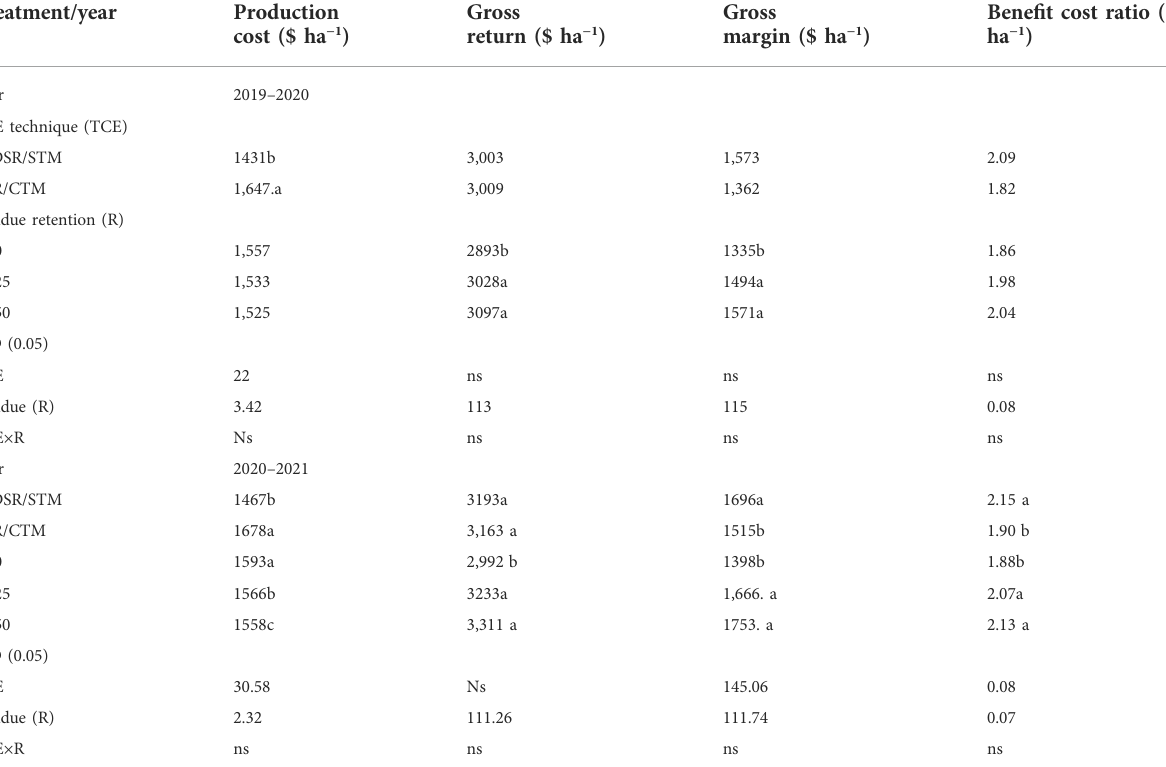
TABLE 6 Economics of different crop establishment techniques and residue management options in rice-maize cropping system during 2019 – 2020 and 2020 –